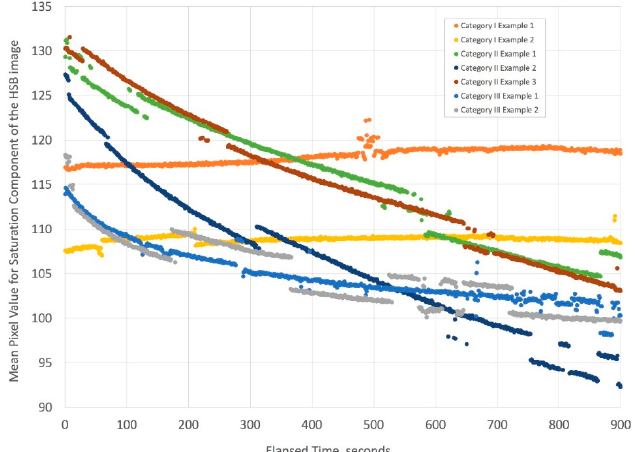
the same density and viscosity. The three separate experiments for Category II, which are for liquid conditions where Korteweg stresses and viscous fingering can occur, show a steep decline in mean pixel value over time. Finally, the two separate experiments for Category III, where liquid conditions generate Korteweg stresses, show a shallower decline in the mean pixel value over time. Owing to slight variations in lighting for short times during the time-lapse videos, there are minor discontinuities in the mean pixel values, but the curves retain similar slopes. Overall, the trend for Category I (duplicate) is essentially that there is no substantial mixing of the liquids, while the decline in mean pixel values seen for Categories II (triplicate) and III (duplicate) are the result of decreases in pixel saturation due to mixing of the yellow and blue color liquids to yield the color green (see Supplemental